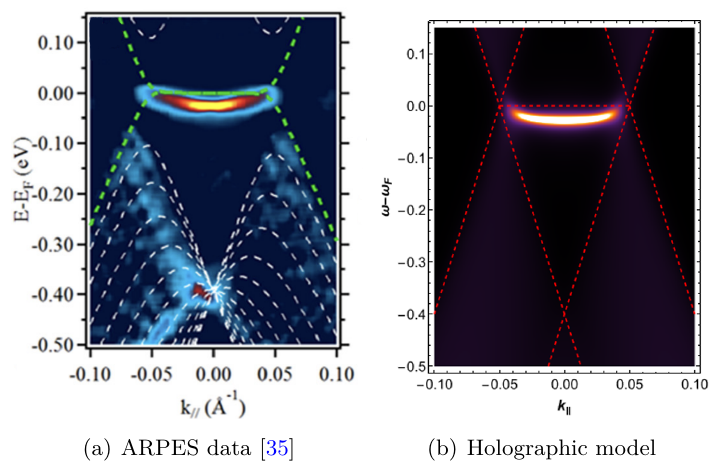
Figure 5 . Comparision experimental data and holographic model: (a) Angle-resolved photoemission spectroscopy(ARPES) data of ABC-MLG film for 14-layers, dashed line denote band structure especially green one means surface state [35], (b) the spectral function of holographic ABC-MLG model with B ( − 1) xy = 0 . 05 , µ = 0 . 075 , and some scaling for ω , red dashed line denote overall bend structure coming from the tight-binding